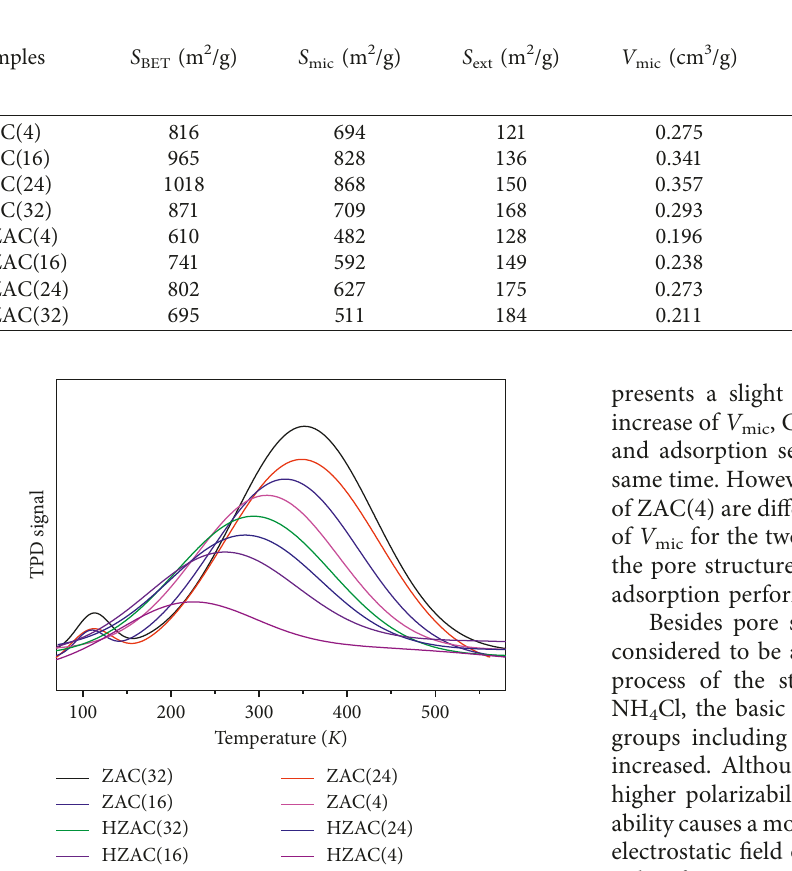
Figure 3: CO 2 -TPD of ZAC( t a ) and HZAC( t a ).